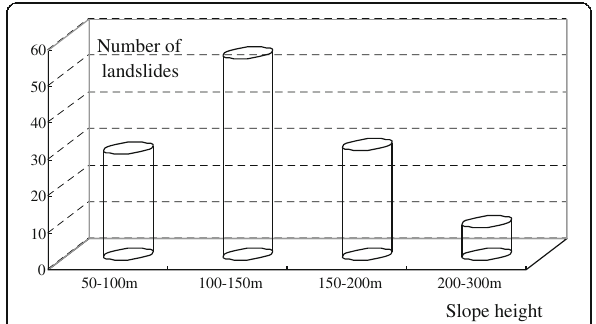
Fig. 16 Relationships between slope height and landslide occurrence